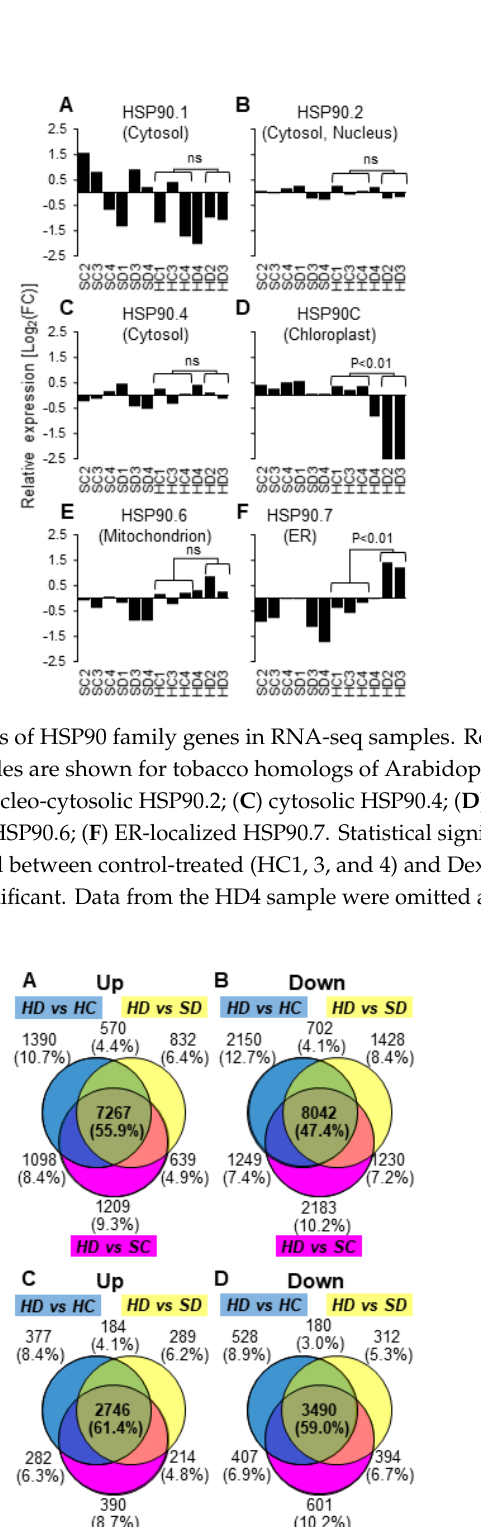
ff erentially expressed genes. Results from di ff erential expression analysis Figure 3. Venn diagrams of differentially expressed genes. Results from differential expression Figure 3. Venn diagrams of di with DESeq2 were considered in three di ff erent comparisons: Dex-treated H-4 vs. control H-4 (HD vs. HC), Dex-treated H-4 vs. Dex-treated SR1 (HD vs. SD), and Dex-treated H-4 vs. Control SR1 (HD